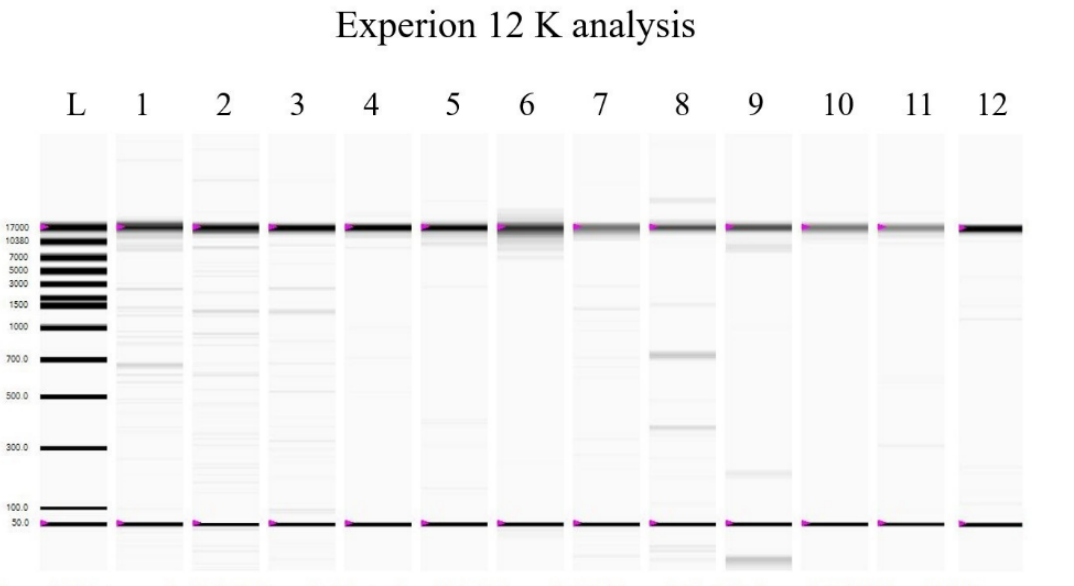
Figure 8. Genomic DNA from mock-inoculated Westar (Westar-mock), Westar inoculated with L. maculans (Westar-Lm), mock-inoculated 74-44 BL (74-44-mock), and 74-44 BL inoculated with L. maculans (74-44-Lm), separated on an Experion 12K chip in order to assay genomic DNA degradation as a marker of programmed cell death.